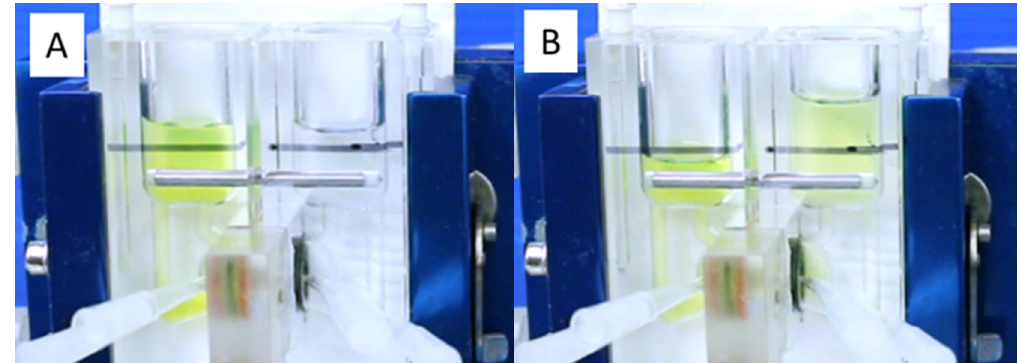
Figure 3. Photos immediately after 4 kD FITC-dextran was added to the basolateral chamber ( A ) and after 5 min of vigorous aeration ( B ) showing the movement of both fluid and FITC-dextran from the basolateral to the apical chamber and establishment of a hydrostatic pressure gradient.